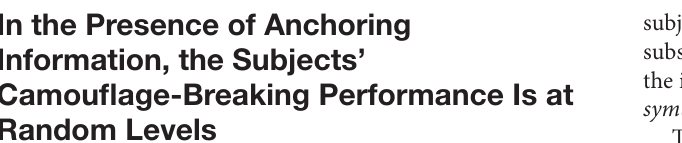
FIGURE 3 | Results of Experiment 2. (A) exemplar stimuli used in Experiment 2. (B,C) ROC analysis of the subjects’ final estimates in the absence and presence of anchoring information,